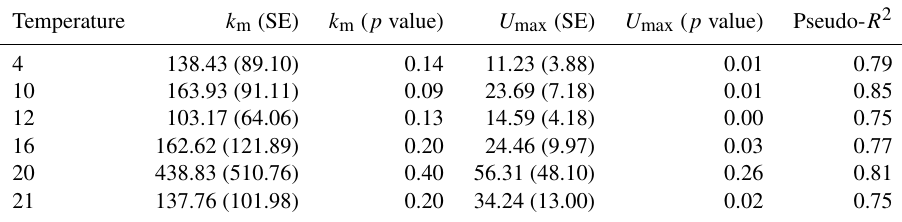
Table A2. Regression coefficients and model fits associated with Fig. 3a in the main text. Data were grouped by temperature and Michaelis– Menten models were fit to the data. Estimates of K m and U max along with the associated standard errors (SEs) and p values are presented here. We also present a pseudo- R 2 which is calculated as 1 minus the ratio of the residual sum of squares divided by the total sum of